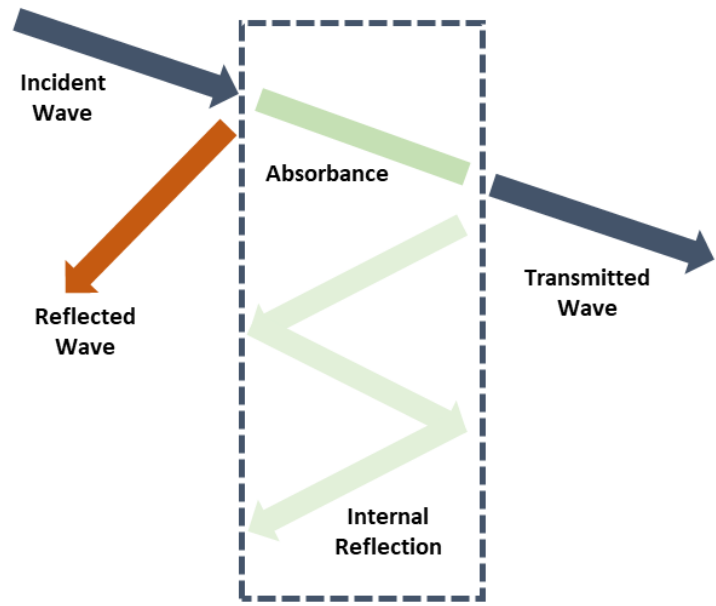
Figure 6. EMSE mechanisms.